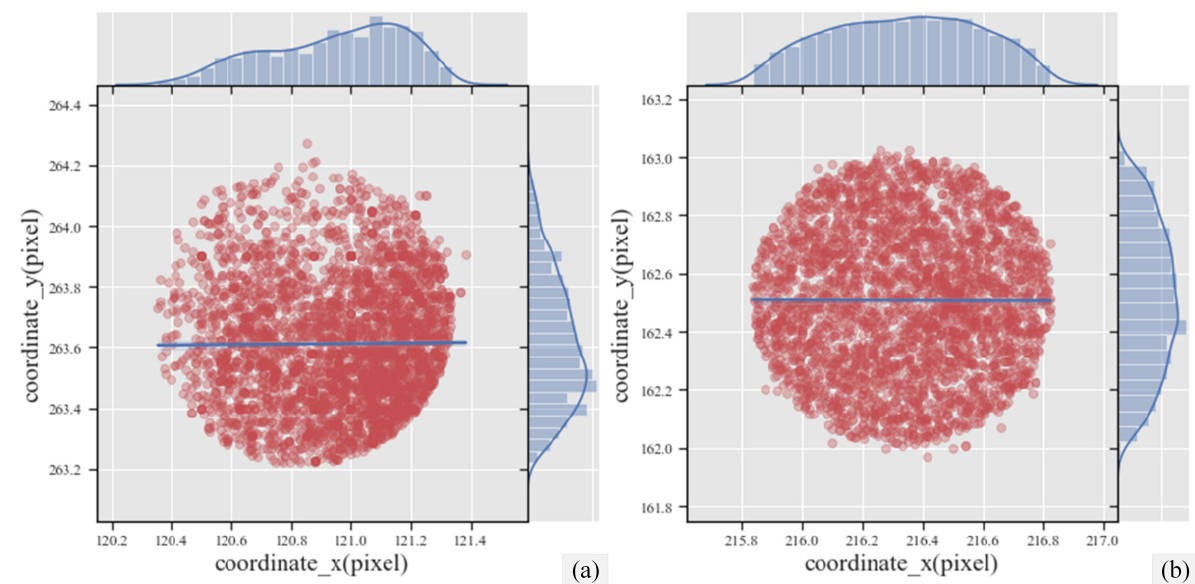
Figure 6. Centroid coordinate statistics for the laser footprint image (LFI) of laser 1 ( a ) and 2 ( b ).